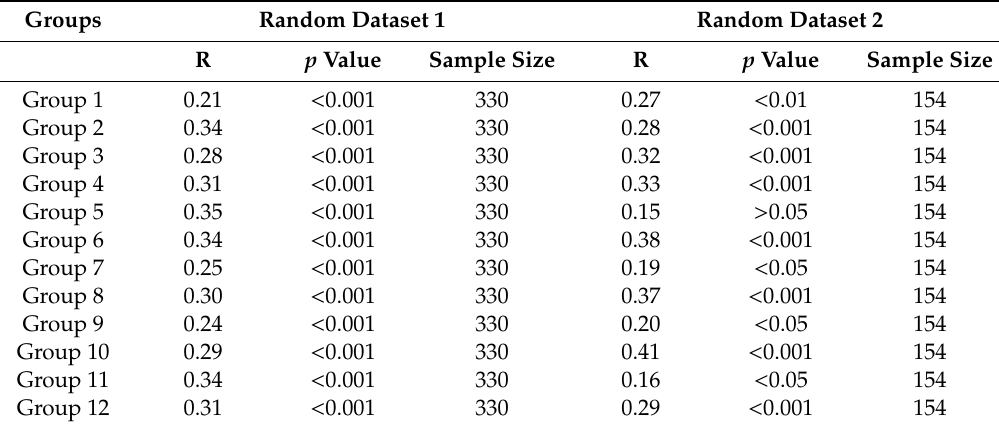
Table 4. Correlation coe ffi cient R between each group and the sum of the random datasets. Groups 1–12 represent random monthly flux while the sum represents the random annual